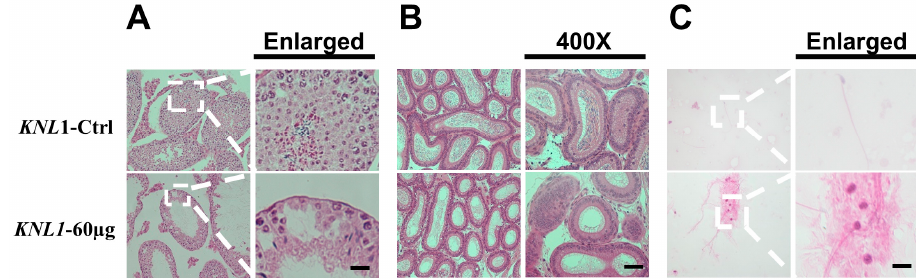
bar = 1 mm. ( C ) The degree of difference between the KNL1 -Ctrl mice and KNL1 -60 µg mice. Data were presented as mean percentages (mean ± SEM) of at least three independent measurements. Asterisk denotes statistical difference level of significance (*, p < 0.05; ns > 0.05).